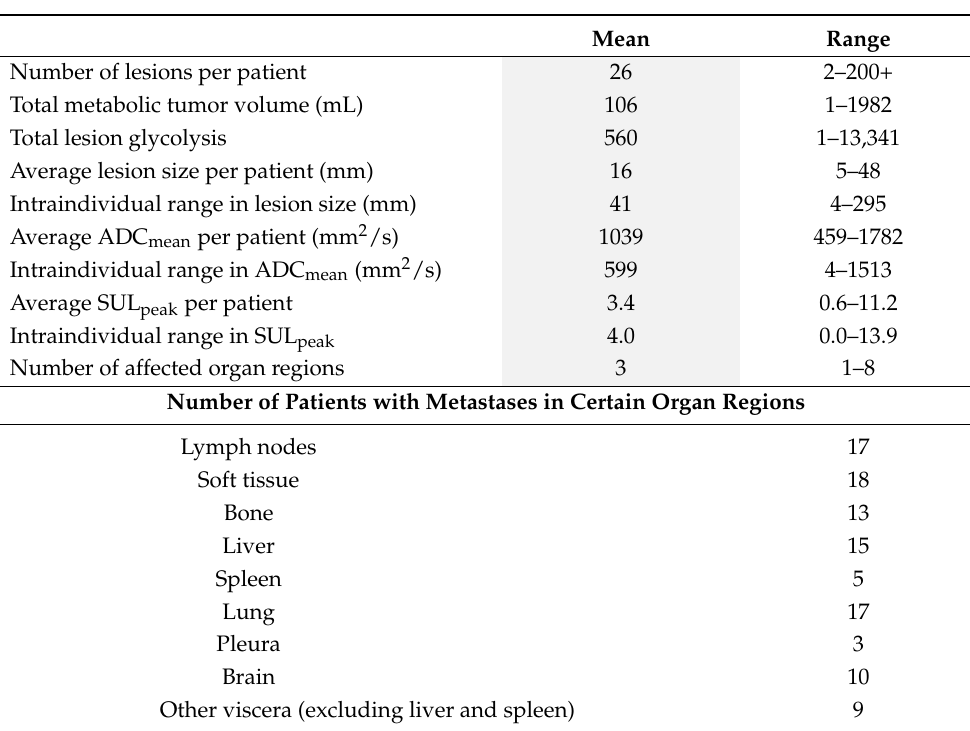
Table 2. Results of lesion evaluation in patient